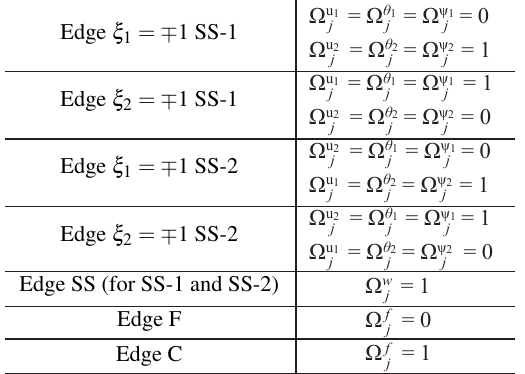
( f ) Table A1 gives the exponents Ω for the classical geometric boundary condition of the RZT, according to j the prescribed (geometric) values given in Section 2.7.